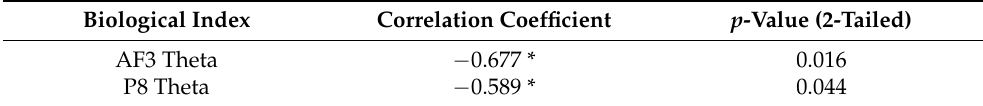
Table 12. Correlation coefficients between the number of errors in Task2 and the mean values of